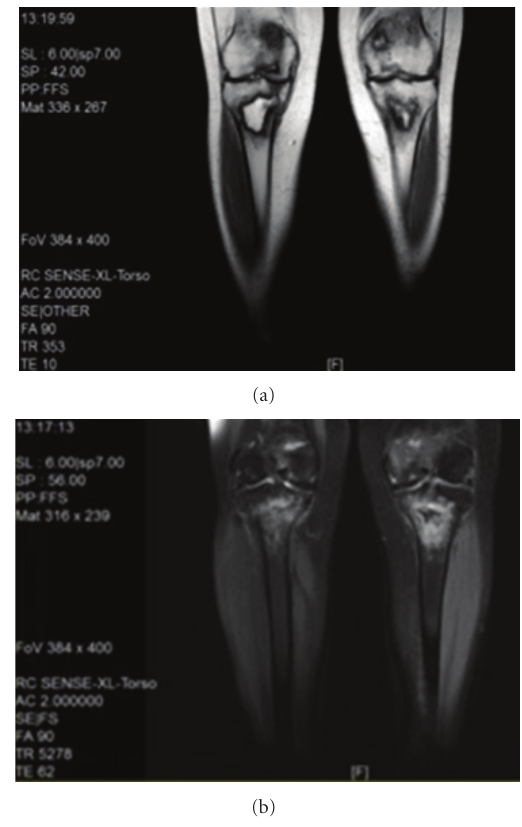
Figure 2: Signal changes in distal femur and metaphyseal- diaphyseal region of tibia consists with bone infarction in T1 (a) and T2 (b) weighted